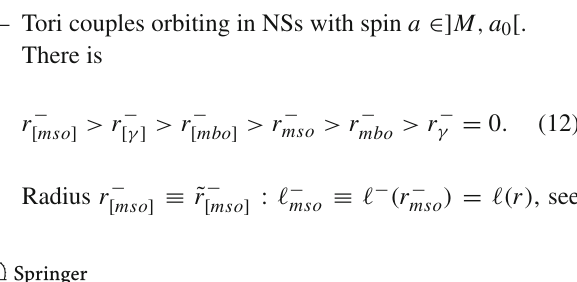
Fig.1,regulatestheouterco-rotatingtoruscenterlocation and constitutes a main difference with the BH